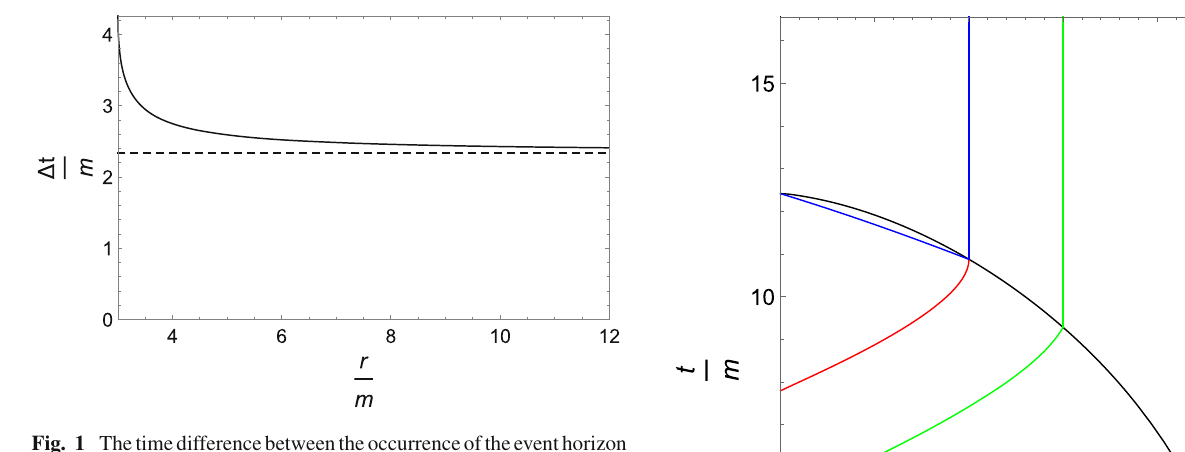
√ 6 − 8 )/ 6 ) m ≈ 2 . 3409 m